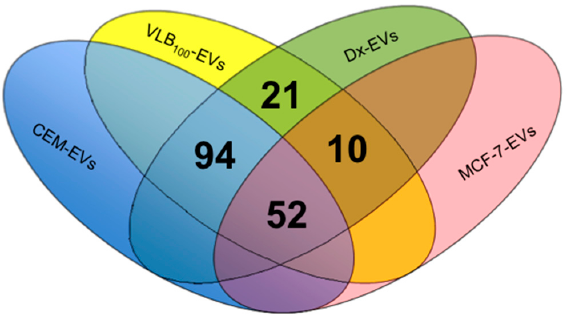
Figure 2. Proteomic profiling by LC/MS/MS. EVs derived from leukemic cells were compared to the proteome of resistant breast cancer-derived EVs [1]. LC-MS/MS identified a total of 589 EV proteins with 177 proteins common to both the MDR breast cancer EVs (Dx-EVs) and MDR leukemic EVs (VLB 100 -EVs). Included here were P-gp, Ezrin, Radixin and Moesin.